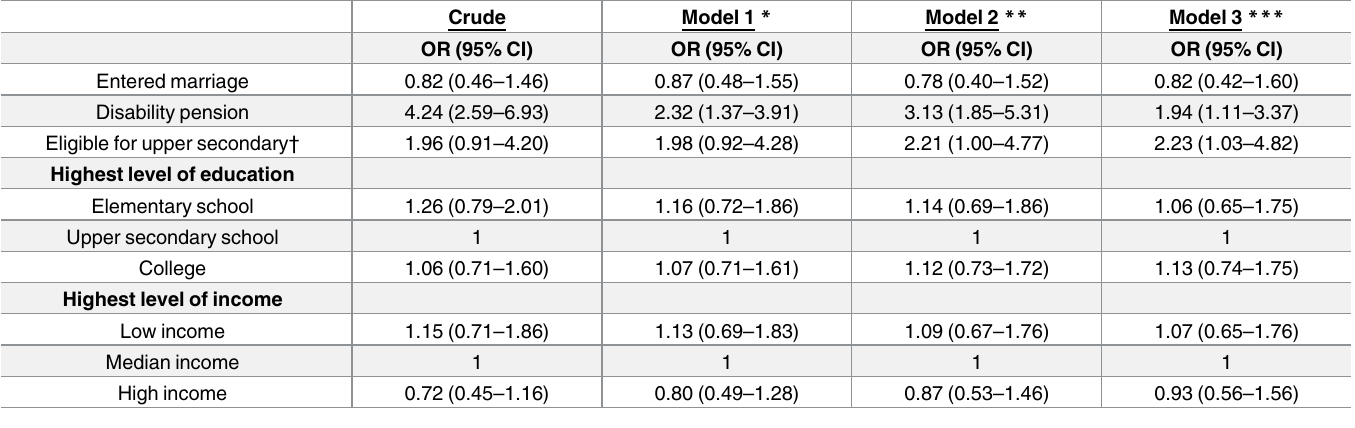
Table 4. Logistic regression models for the associations between proximal hypospadias and socioeconomic